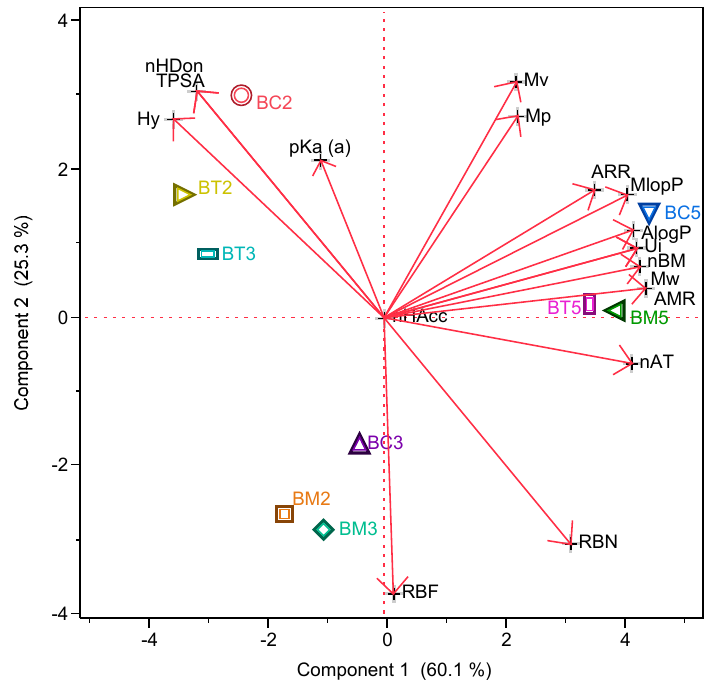
Figure 2. Principal Components Analysis (PCA) showing the position of the tested compounds according to their selected molecular